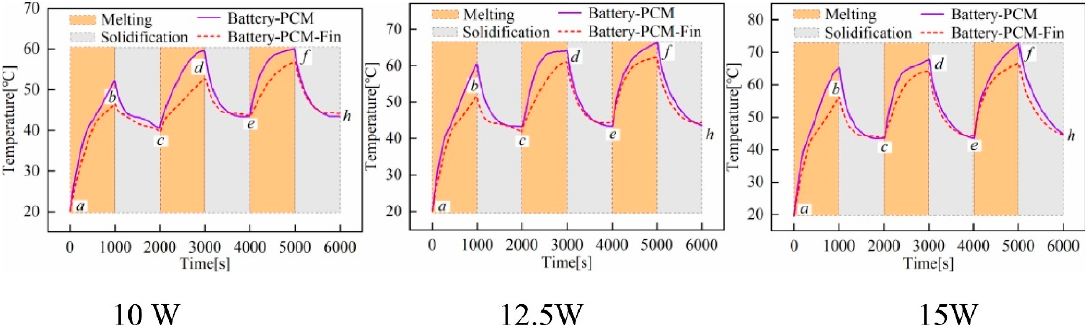
Figure 9. Battery cell surface temperature during cycling test [54]. Reproduced with permission from Elsevier.